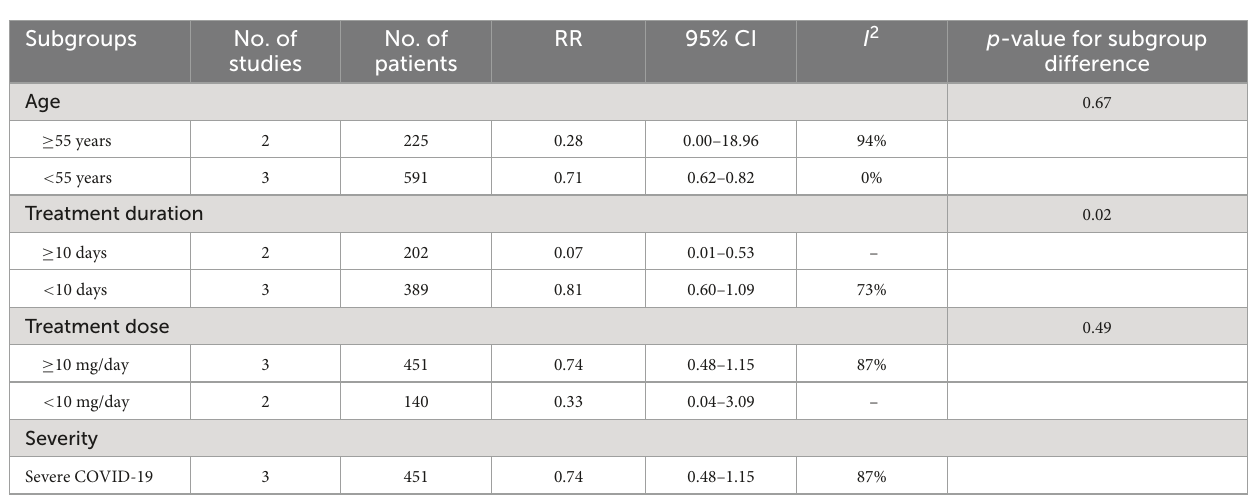
TABLE 2 Summary of subgroup analyses for primary